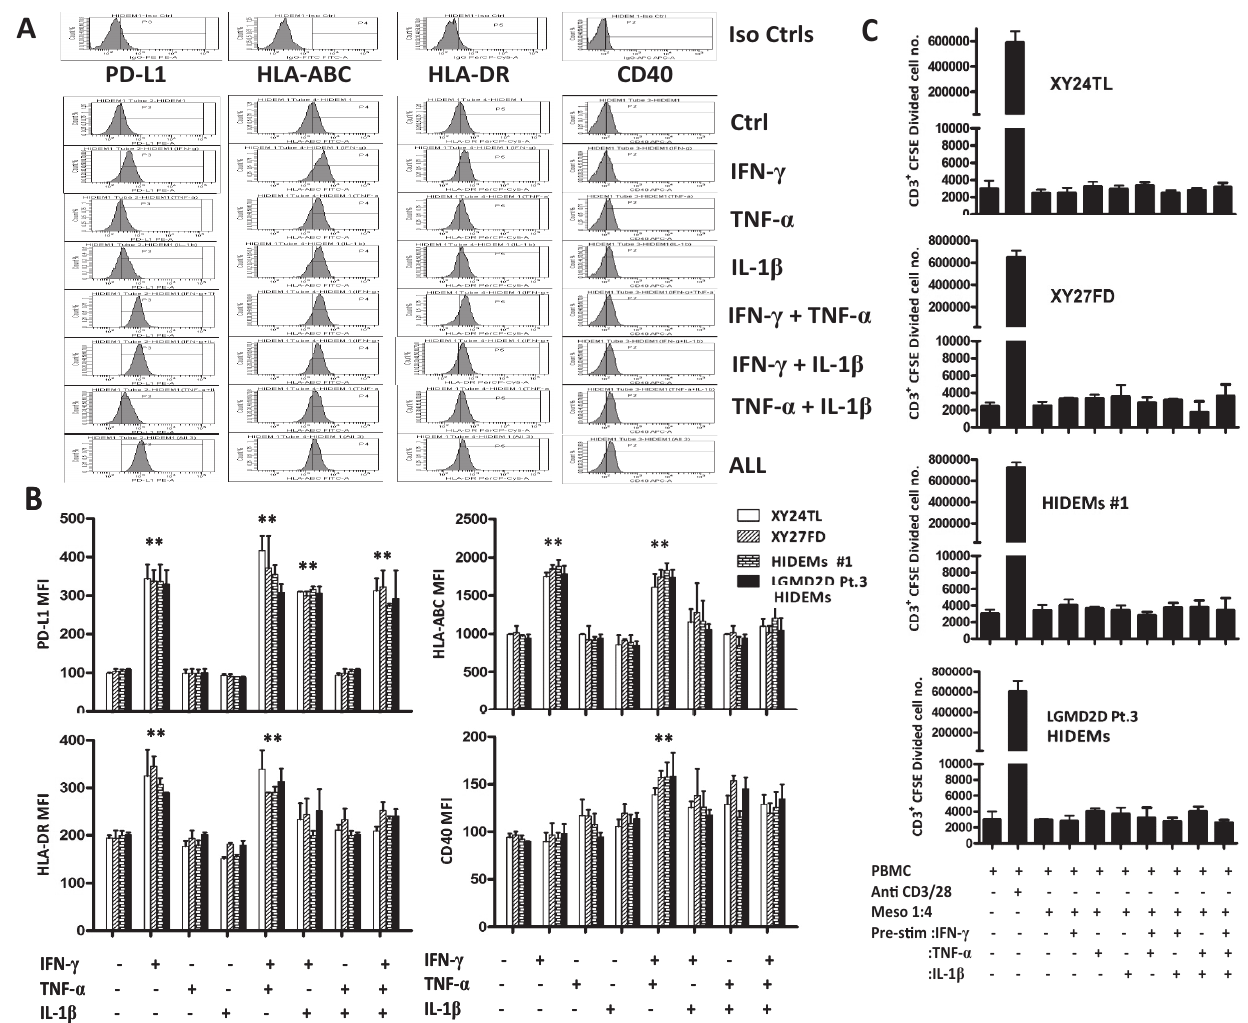
Figure 2. HIDEMs and mesoangioblasts fail to induce T cell proliferation in vitro . HIDEMs and mesoangioblasts were stimulated with IFN- γ , TNF- α or IL-1 β (20ng/ml) for 24h. Cells were trypsinized and washed, followed by surface staining for HLA-ABC, HLA-DR, CD40, PD- L1 or fluorochrome matched isotype controls and analysis by flow cytometry. Representative histograms of HIDEMs #1 are presented here ( A ). Data are represented as mean (+/- SE) median fluorescence intensity of the markers examined over 4 replicates. **p<0.01 ( B ). CFSE- labelled PBMCs were stimulated with anti CD3/CD28 beads (PBMC+B) as a positive control. Non-stimulated or cytokine stimulated HIDEMs/ mesoangioblasts (ratio 1:4) were co-cultured with PBMC for 6 days. CD3 + CFSE labelled 7AAD - cells were enumerated using counting beads ( C ). Experiments were carried out in duplicates.